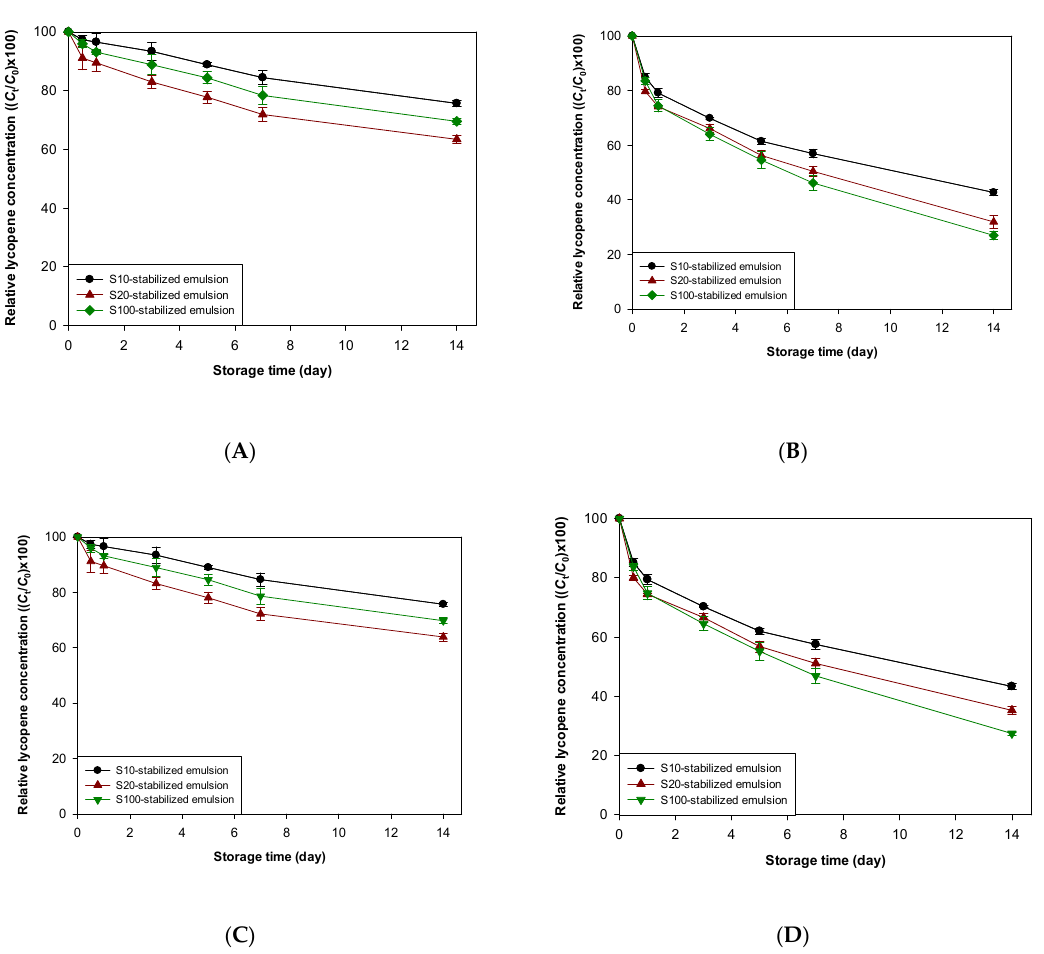
Figure 4. Effect of TBHQ ( A , B ) and lauryl gallate ( C , D ) on the stability of lycopene concentrations over storage in emulsions stored at 25 °C at pH 7 ( A , C ) and 3 ( B , D ) in the presence of water-soluble radicals. C 0 , initial lycopene concentration in emulsion; C t , lycopene concentration in emulsion at t day of storage.